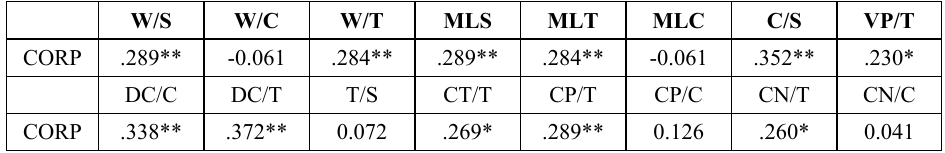
Table 3. Correlation between WECCL and LOCNESS in syntactic complexity indices. W/S W/C W/T MLS MLT MLC C/S VP/T CORP .289** -0.061 .284** .289** .284** -0.061 .352** .230* DC/C DC/T T/S CT/T